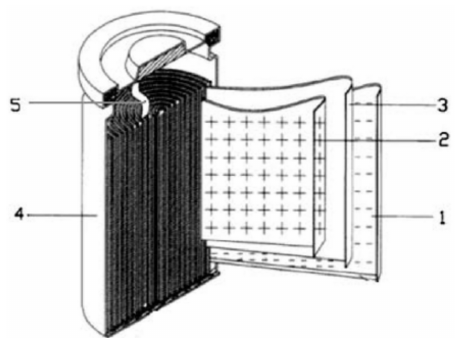
Figure 10. A schematic diagram of a high-power cell design with 1: can, 2: positive electrode, 3: separator, 4: negative electrode, and 5: tap having more than 4 welding spots to the positive electrode